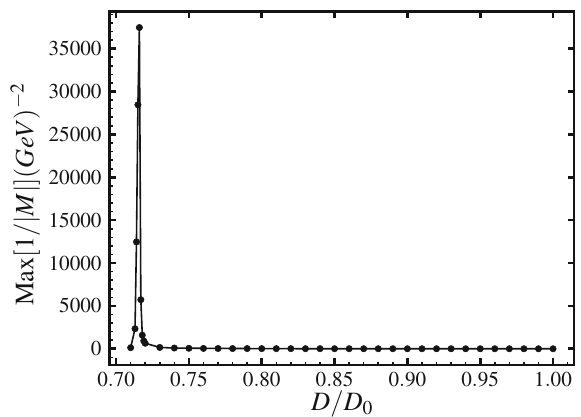
Fig. 2 Calculatedcoupling strength D dependence of the denominator 1 / | M | defined in Eq. (11), with the critical chemical potential μ q , c = 307 . 6 MeV, and dressed gluon propagator in the Gaussian-type with D = D 0 = 1 . 0 GeV 2